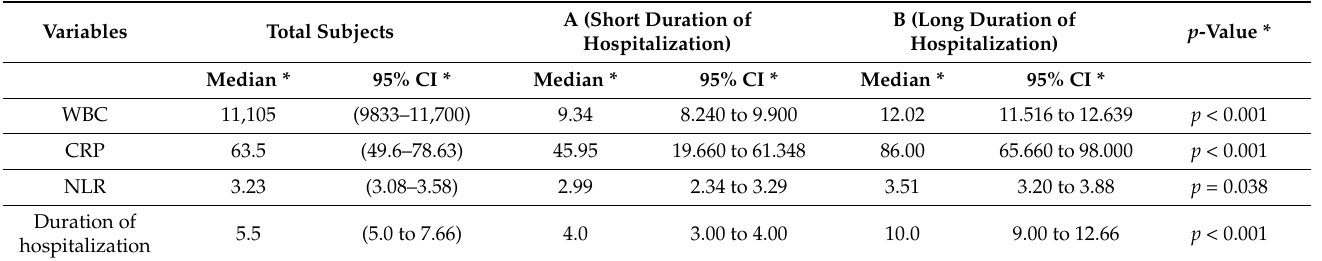
Table 2. Study markers and duration of